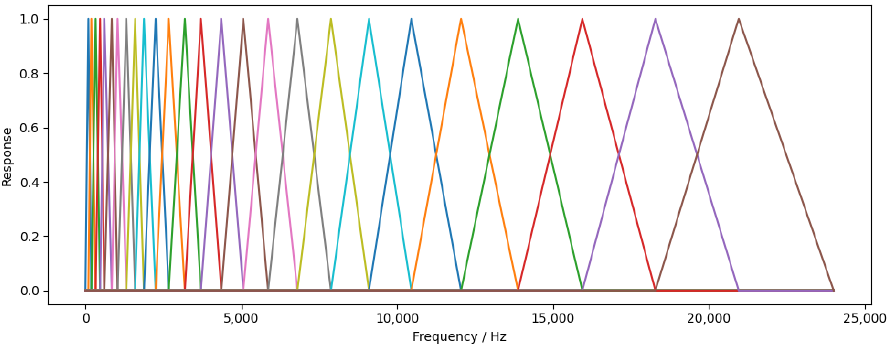
Figure 11. Mel filter bank.